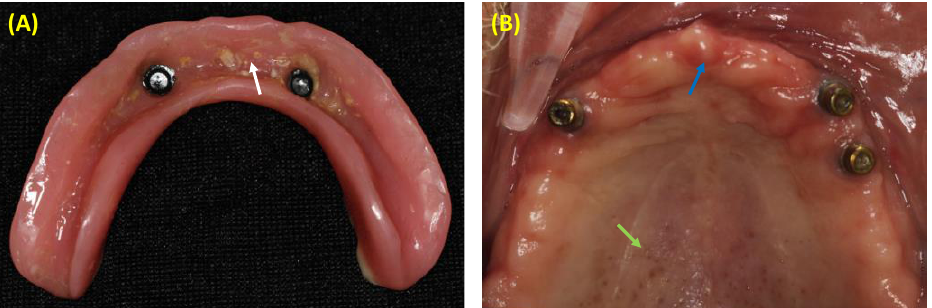
Figure 1. Clinical photos: ( A ) Mandibular overdenture with biofilm accumulation (white arrow), which could be associated with the onset of denture stomatitis; ( B ) Edentulous maxilla representing the clinical features of denture stomatitis such as pinpoint inflammation of minor salivary glands (green arrow), and diffuse erythema of the anterior alveolar ridge (blue arrow).